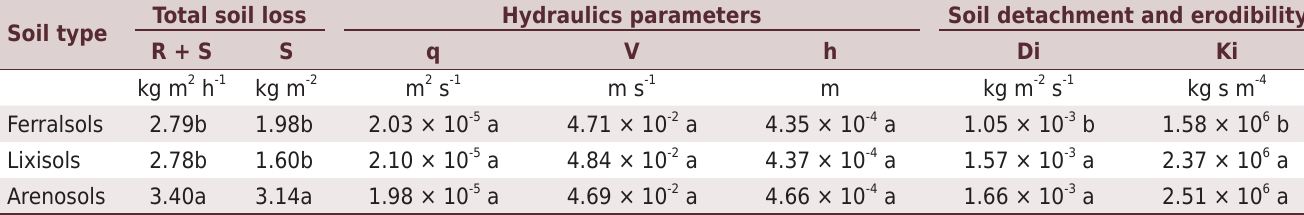
Table 2. Average of soil loss, flow characteristics, interrill detachment, and interrill erodibility according the soil type along the catena Total soil loss Soil type